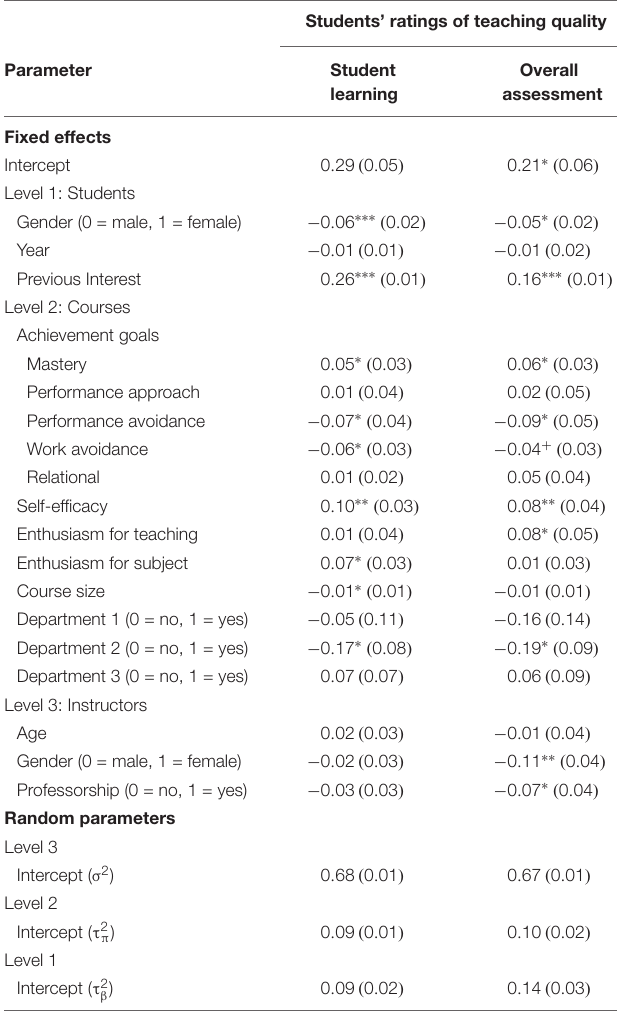
TABLE 4 | Relations of instructors’ achievement goals, self-efficacy, and enthusiasm with student evaluations of teaching